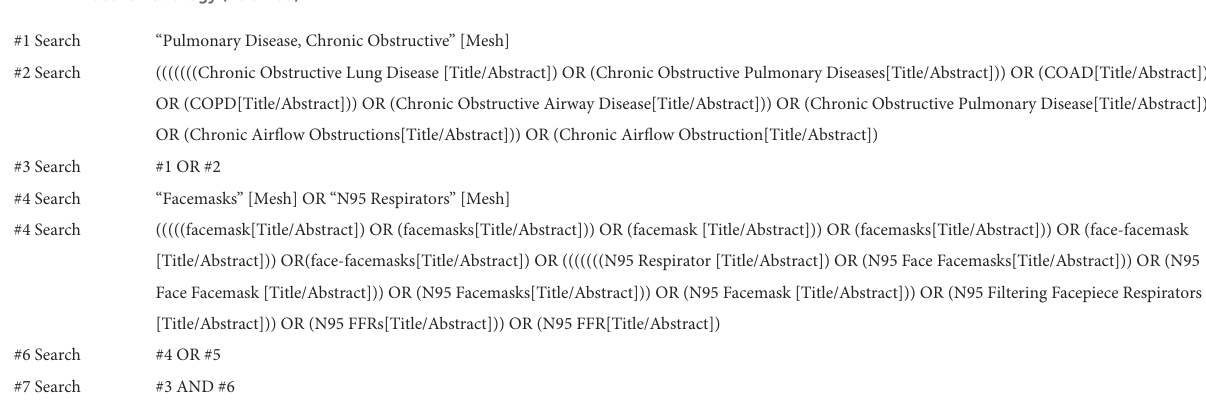
TABLE 1 Search strategy